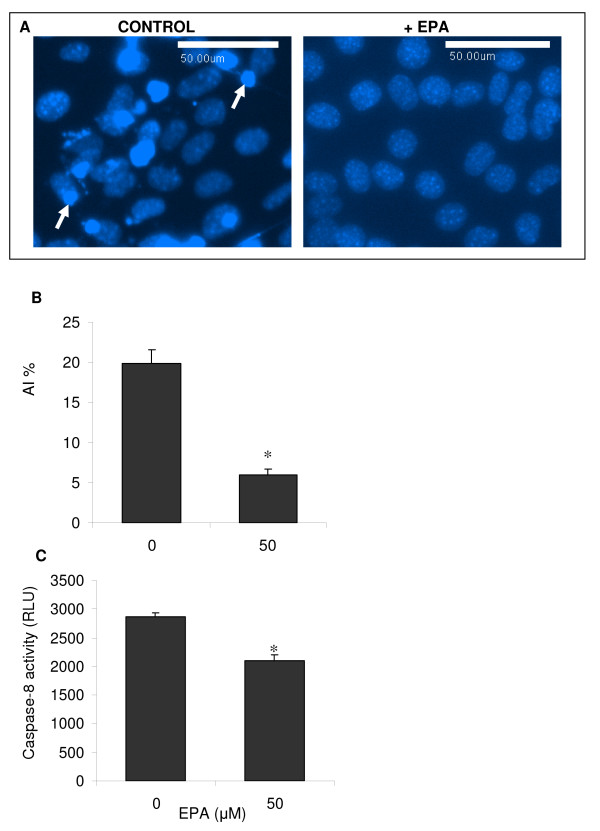
EPA blocks baseline C2C12 apoptosis. C2C12 cells in DM for 5 days were stained with Hoechst 33342 to identify brightly fluorescent, condensed apoptotic nuclei. Representative images are shown in (A) for cells in the presence or absence of 50 μM EPA with arrows indicating example apoptotic nuclei. A semi-quantitative analysis was performed by calculating an apoptosis index (AI%) from these images (B). Quantitative analysis of caspase-8 activity (measured in relative light units, RLU) from cultures in the presence or absence of EPA was evaluated using the Caspase Glo-8 commercial assay (C). Data are expressed as means ± standard error of mean (SEM) from 3 independent experiments. (*p < 0.05 v. control). Calibration bars are 50 μm.